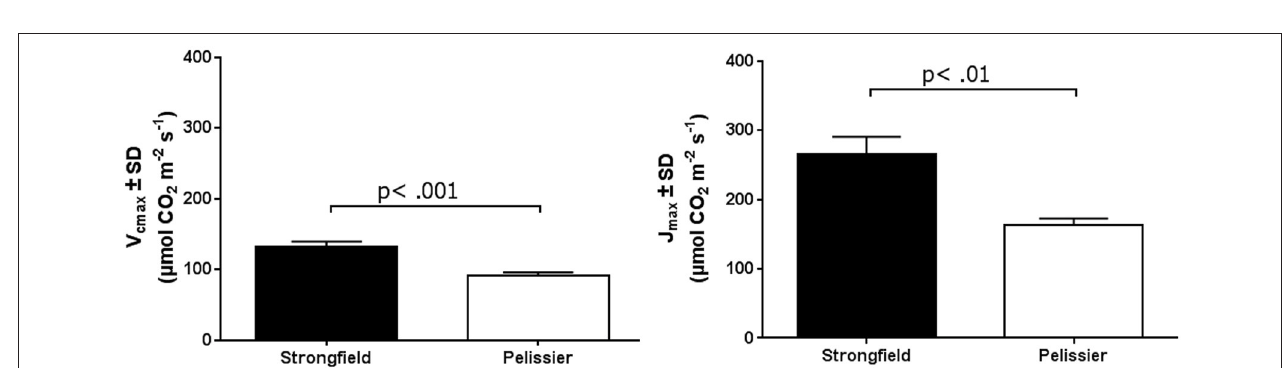
FIGURE 3 | V cmax and J max of Strongfield and Pelissier as determined from CO 2 curves of 3 well-watered plants per variety.